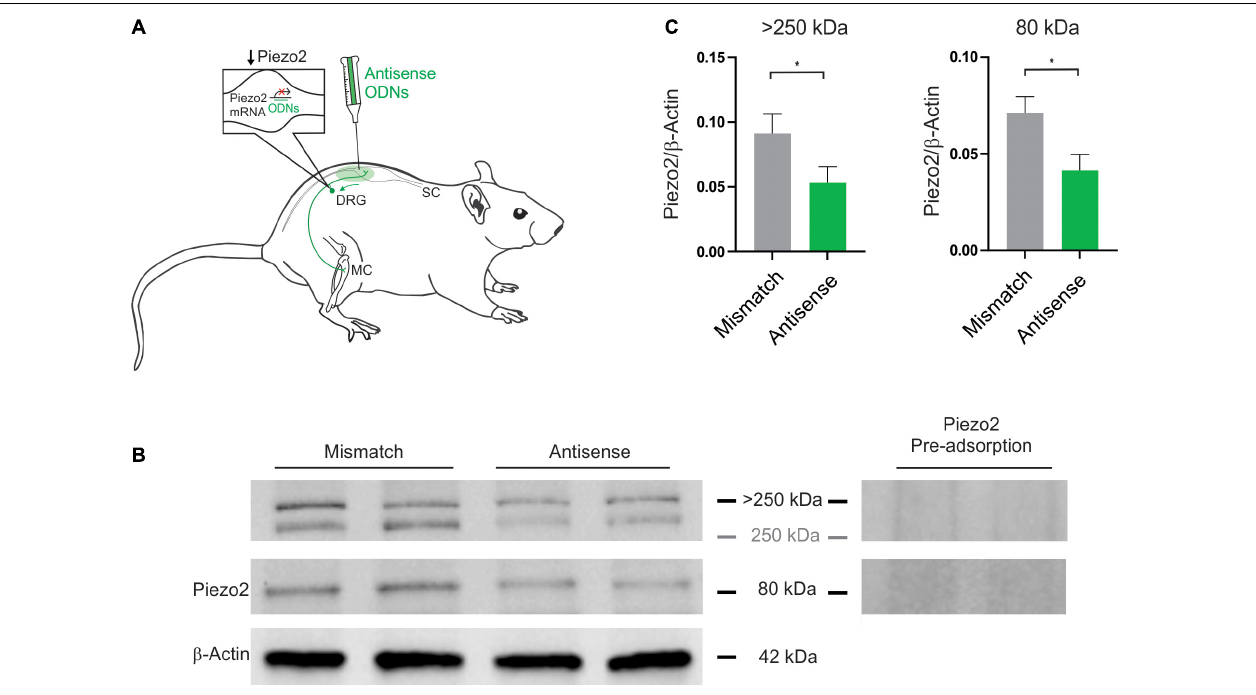
FIGURE 1 | Piezo2 knockdown approach and confirmation of protein knockdown. (A) Piezo2 antisense or mismatch oligodeoxynucleotides (ODNs) were administered by intrathecal injection. (B) Western blot analysis revealed that the intensity of the bands > 250 kDa, and at 80 kDa, are significantly reduced by administration of Piezo2 antisense, relative to mismatch ODNs. Pre-adsorption of the Piezo2 antibody with the manufacturer’s peptide (Piezo2 antibody blocking peptide, Novus Biologicals, #NBP1-78624PEP) at 5 µ g/ml completely abolishes Piezo2 protein bands at > 250 kDa, and at 80 kDa, in rat DRG. (C) Densitometry analysis revealed a significant reduction in the ratio of Piezo2/ β -Actin in the DRG of animals injected with Piezo2 antisense ODNs ( n = 6) relative to mismatch control ODNs ( n = 6). Data represents mean ± SEM, * P < 0.05, unpaired t